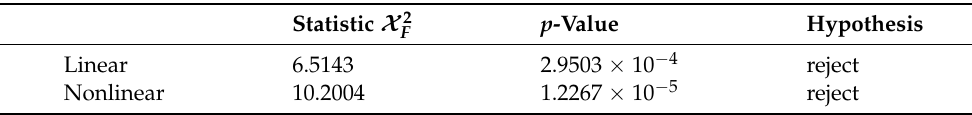
Table 4. Results of Friedman test on learning